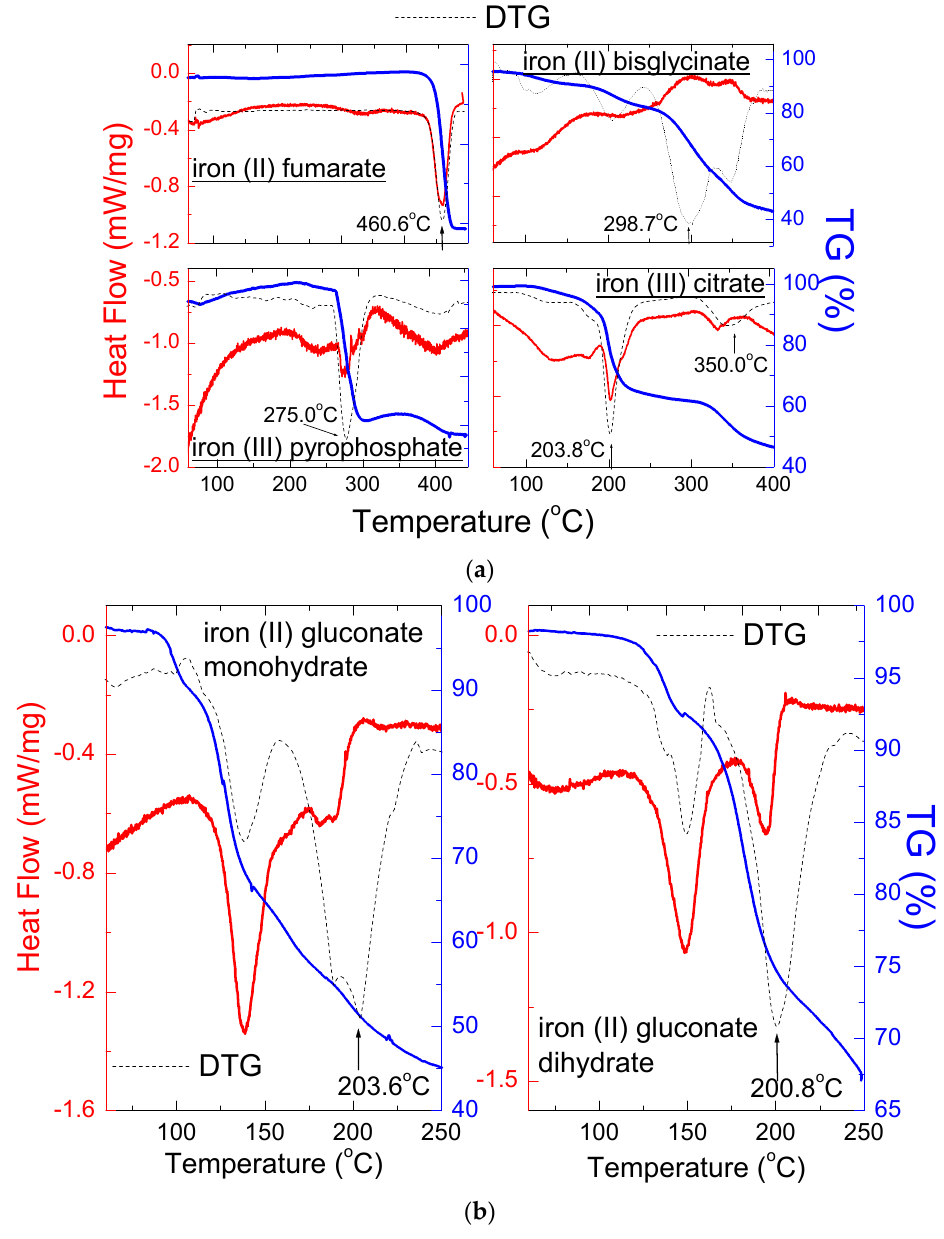
Figure 7. DSC and TG/DTG curves of pure iron compounds: iron (II) fumarate, iron (III) pyrophosphate, iron (II) bisglycinate and iron (III) citrate ( a ) and for iron (II) gluconate monohydrate and iron (II) gluconate dihydrate ( b ).